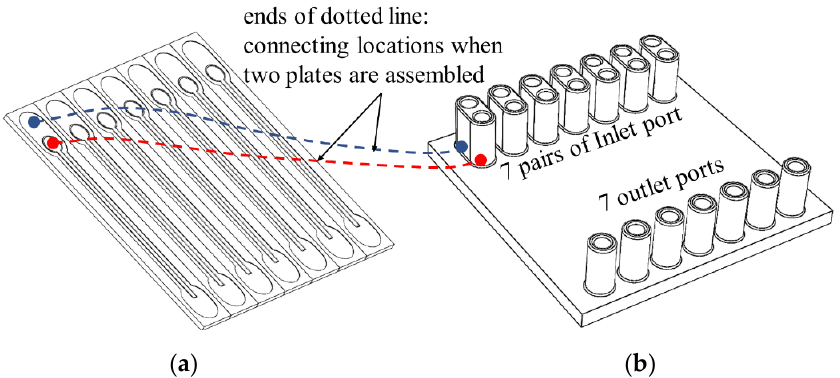
Figure 2. Parts for liposome synthesizing micro-channel device: ( a ) micro-channel plate and ( b ) cover plate.